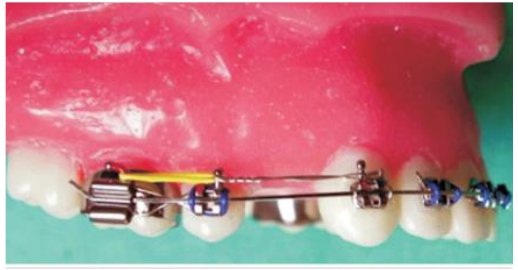
Figure (3): Using of active tie-back for canine retraction (4) Elastic